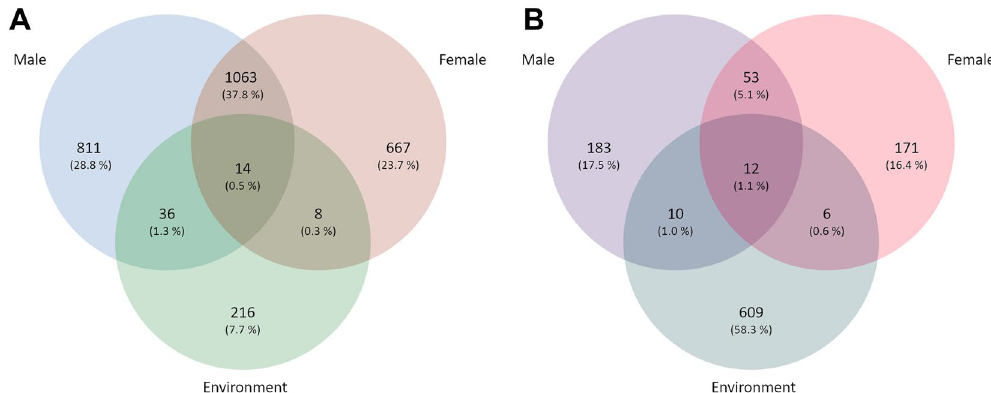
Figure 3. Venn-diagrams showing ASVs in ( A ) the archaeal and ( B ) the bacterial datasets that are unique to or shared between different sample types (male/female/environment). Numbers refer to total ASVs found in the combined DNA and cDNA datasets. The share of the sum of ASVs is given as percentage in brackets behind each